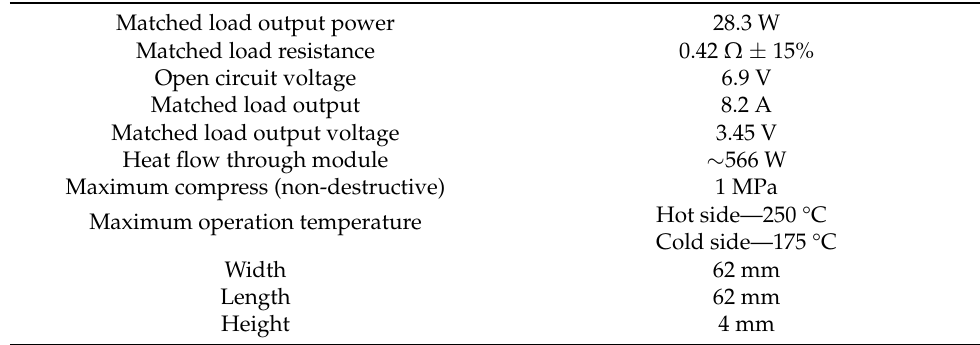
Table 1. Parameters for hot side temp 250 °C and cold side temp 30 °C—adapted from